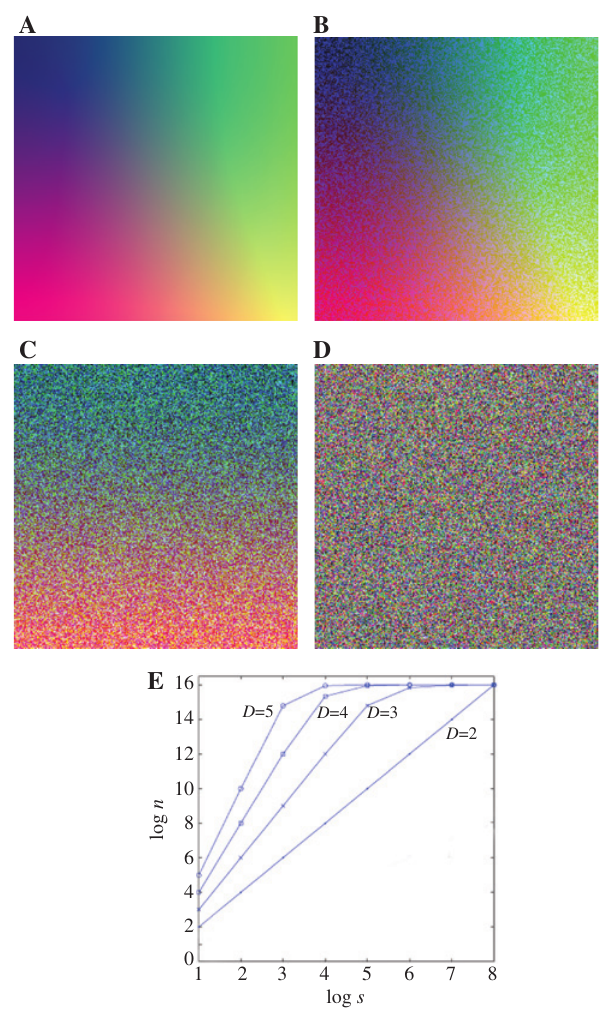
Figure 3: Images with known integer fractal dimensions. (A) Gradient in R and G, B = 128 ( D = 2). (B) Gradient in R and G, noise on B ( D = 3). (C) Gradient in R, noise on G and B ( D = 4). (D) Color noise ( D = 5). (E) log n -log s plots of the test